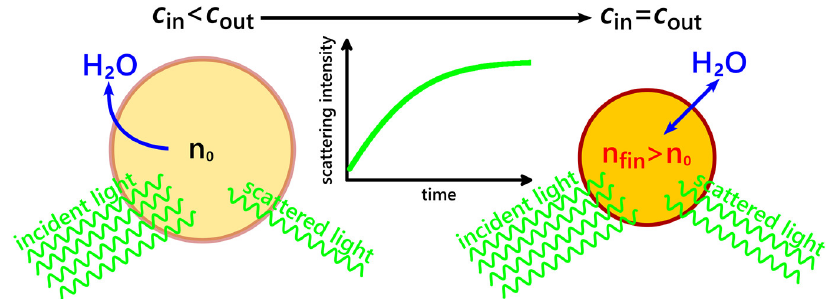
Figure 3. The time course of vesicle volume changes following the introduction of hyperosmotic conditions is accessible via measurements of light scattering intensity I ( t ) of the liposome suspension. I ( t ) is commonly measured under an angle θ of 90°. Although particle size decreases as c in approaches c out and water leaves the vesicles, I ( t ) increases because vesicle deflation increases particle density and, thereby, its refractive index.